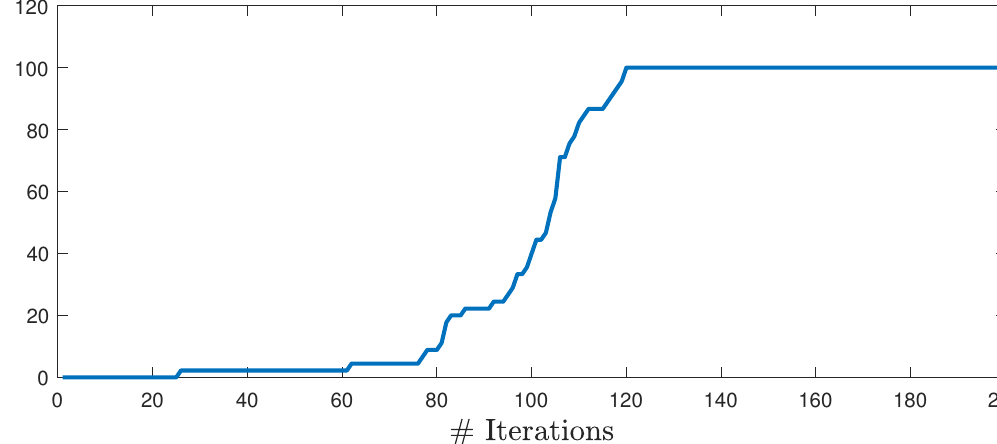
Figure 10. Computed convergence of the solving process in terms of the number of candidate solutions that fulfill strict- design requirements for the first 200 algorithm iterations ( G ≤ 0 in Table